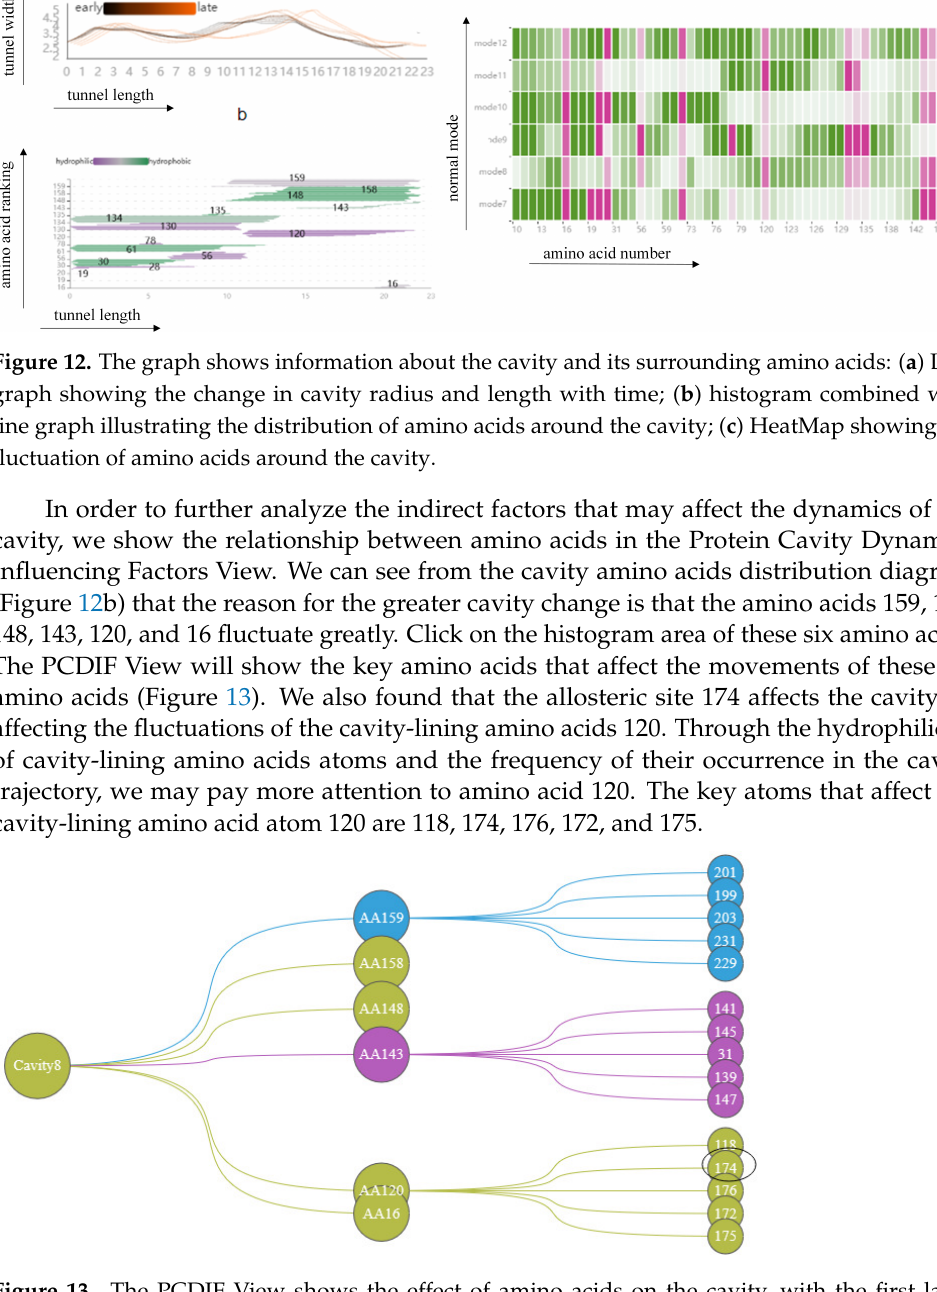
Figure 13. The PCDIF View shows the effect of amino acids on the cavity, with the first layer representing cavity 8, the second layer representing the amino acids surrounding that cavity (AA 159, AA 158, AA 148, AA 143, AA 120, AA 16), and the third layer representing the key amino acids that affect the cavity’s dynamics. The color of the node representing the cluster in which that amino acid is